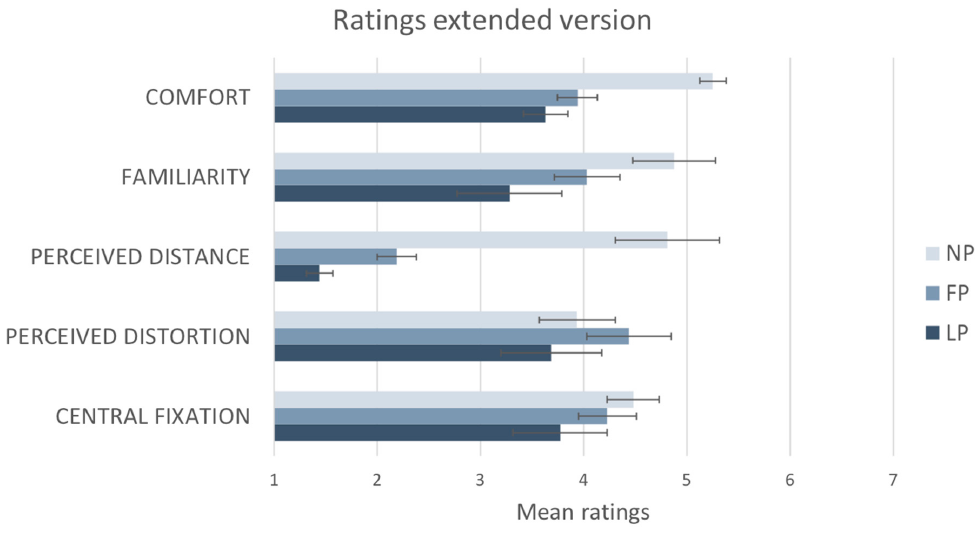
Figure 8. The graph reports the average ratings from the extended version of the questionnaire ( N = 16) on a 7-point Likert scale for each photograph: Natural (NP), Fisheye (FP) and Linear (LP). Standard errors are represented in the figure by the error bars attached to each column.